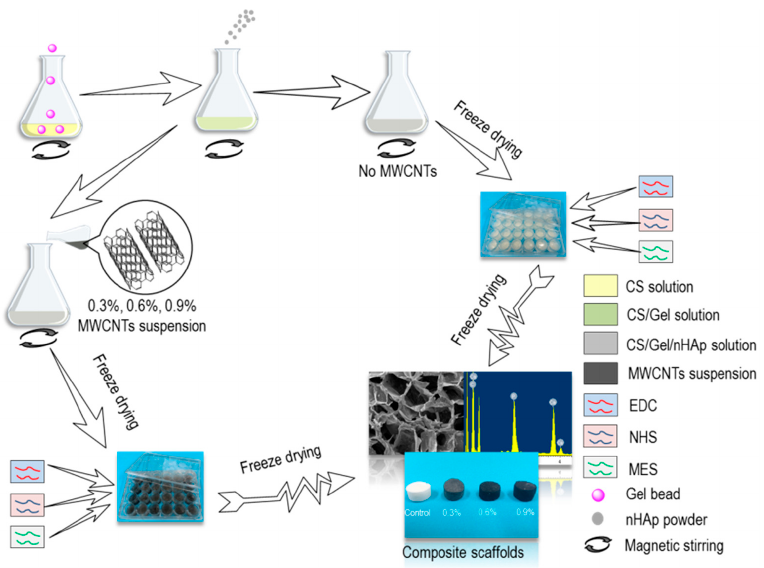
Figure 1. Preparation of CS/Gel/nHAp and CS/Gel/nHAp/MWCNTs composite